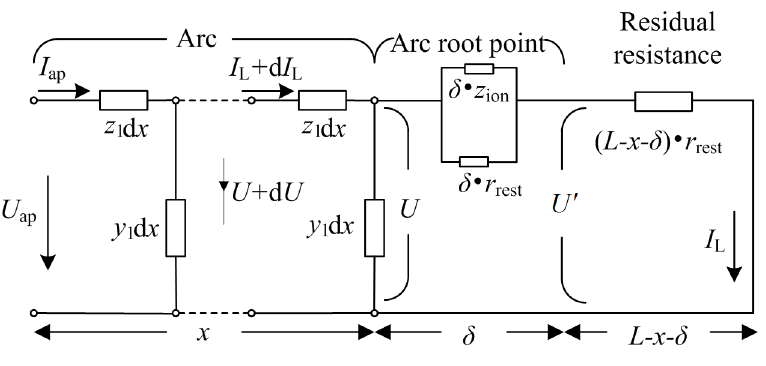
Figure 3. Advanced electrical circuit flashover model.